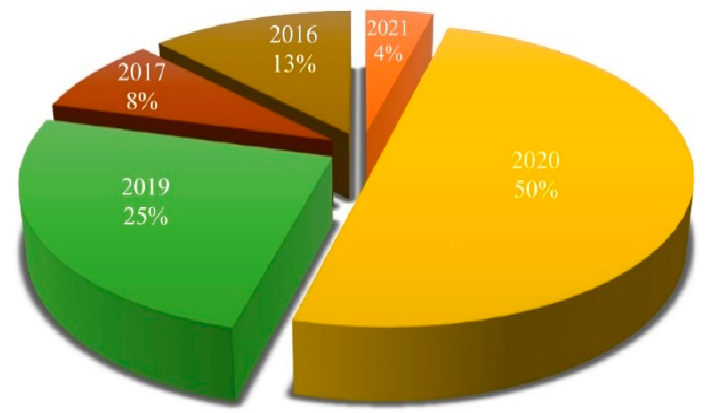
Figure 4. The summary of studies evaluated by the year of publication.